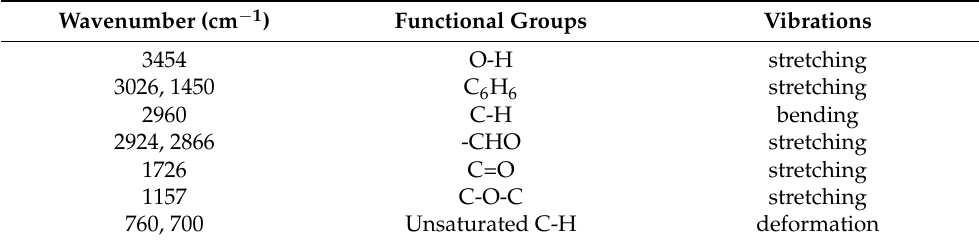
Table 1. Characteristic peaks of the CQD/SAE coating